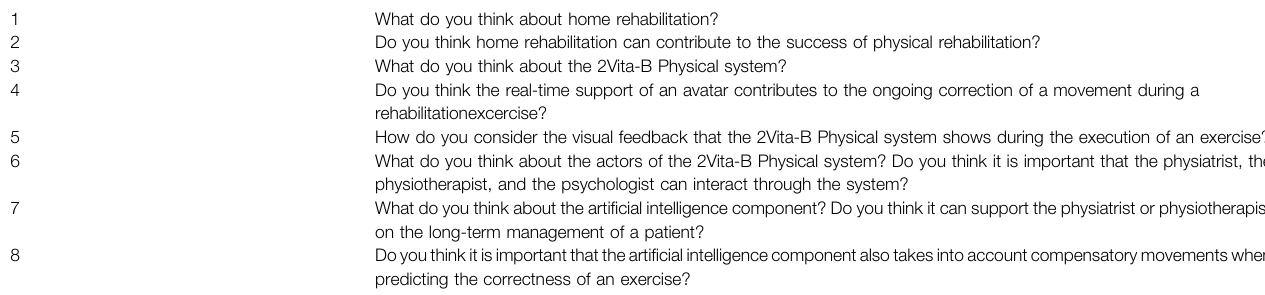
TABLE 3 | The questions asked to the physiotherapist in the context of the structured